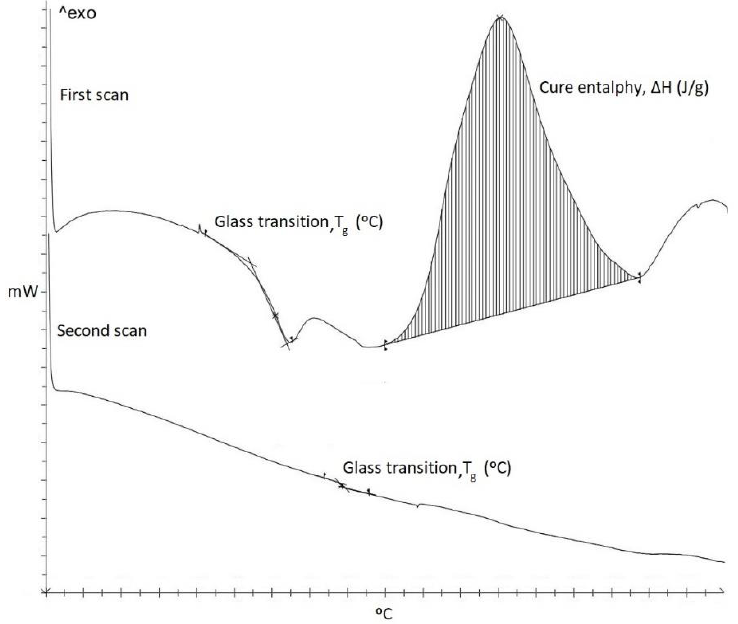
Figure 2. Example of DSC test including first and second scan.